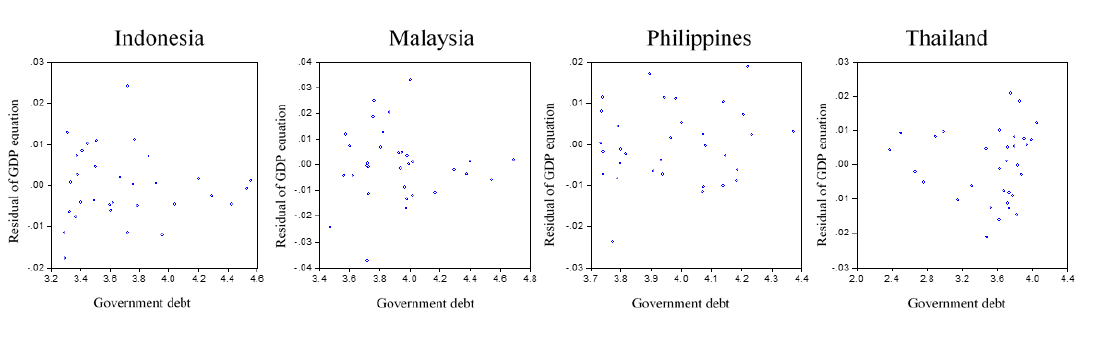
Figure 7: Scatterplot of VAR Residuals (GDP per capita equation) Versus Initial Debt for Indonesia, Malaysia, The Philippines and Thailand, Respectively from Left to